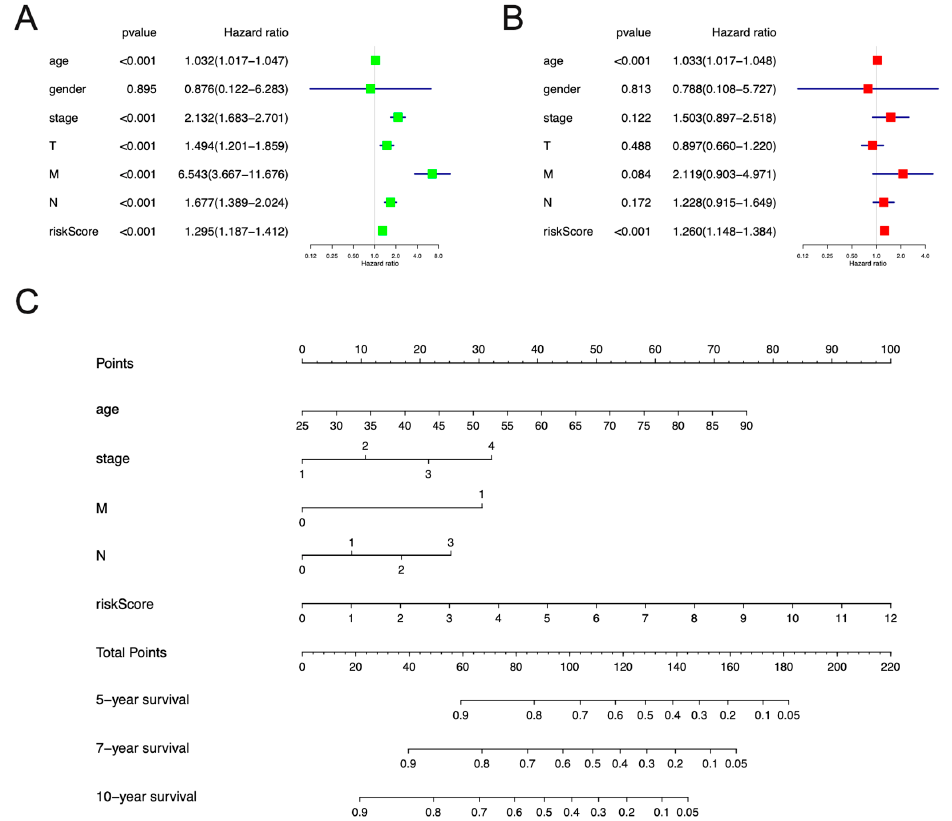
Figure 4. The Cox regression curve analysis and generation of nomogram corresponding to the necroptosis-related risk model. ( A ) The forest plot shows the results of a univariate Cox analysis. ( B ) The forest plot shows the results of a multivariate Cox analysis. ( C ) Based on this necroptosis- related risk model, a nomogram is drawn that predicts 5, 7, and 10-year OS in breast cancer patients.